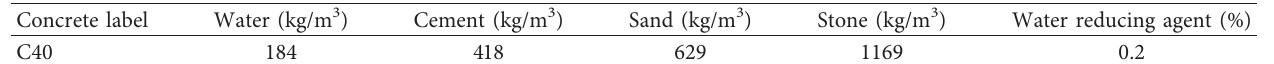
Table 2: The concrete mix